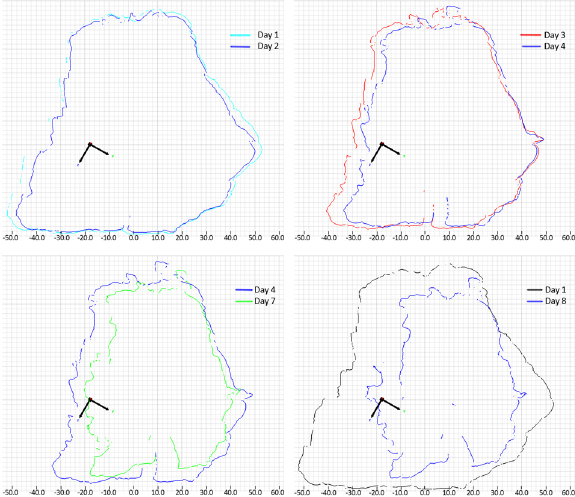
Figure 6. Typical dimensional variations that took place over a period of 8 days (each small square measures 1 mm on the side; tick marks are at every 10 mm).